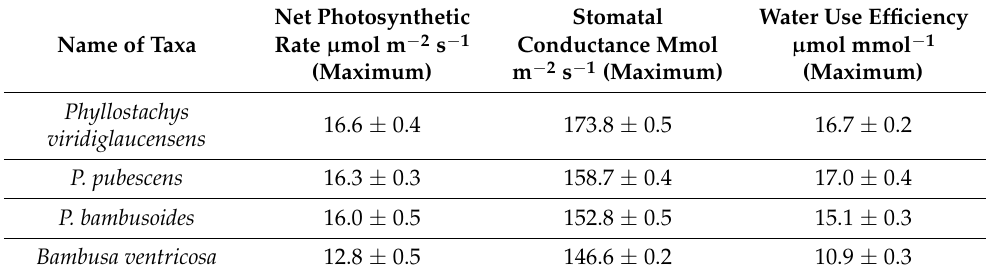
Table 1. Summary of gas-exchange measurements of 4 bamboo taxa in Rome, Italy [17].